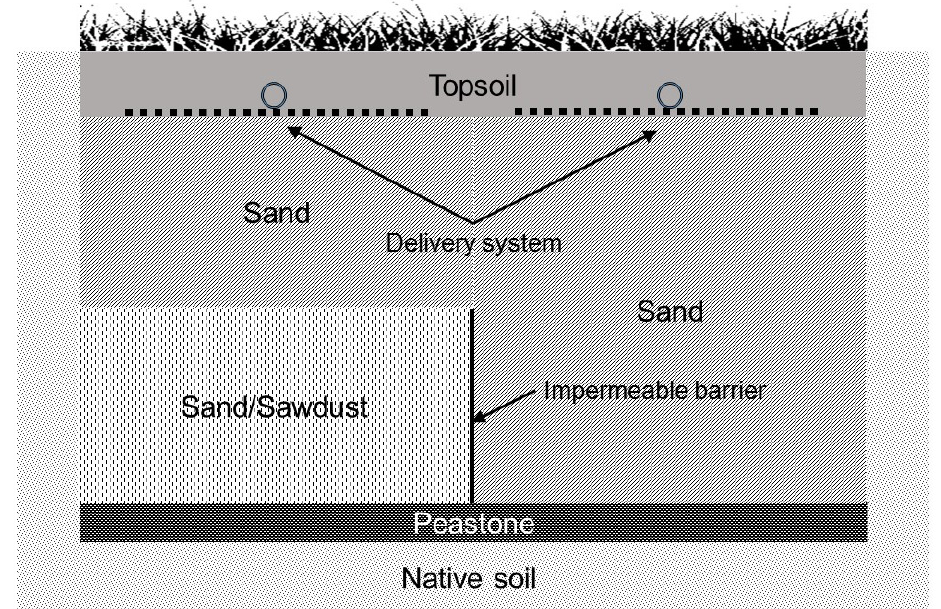
Figure 1. Schematic diagram of a field soil treatment area showing the experimental side with a sand layer over a sand/sawdust layer, and the control side consisting of a single sand layer. The two sides are separated at the bottom by an impermeable barrier. The mesocosm had the same configuration as the experimental side. Drawing is not to scale.